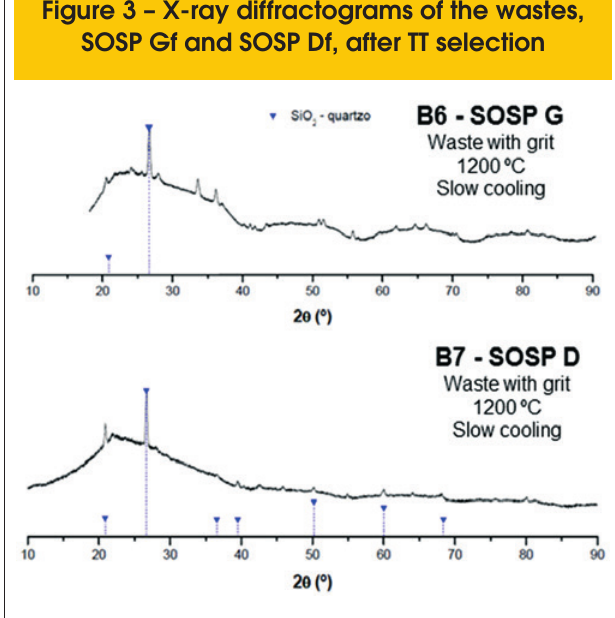
Figure 3 – X-ray diffractograms of the wastes, SOSP Gf and SOSP Df, after TT